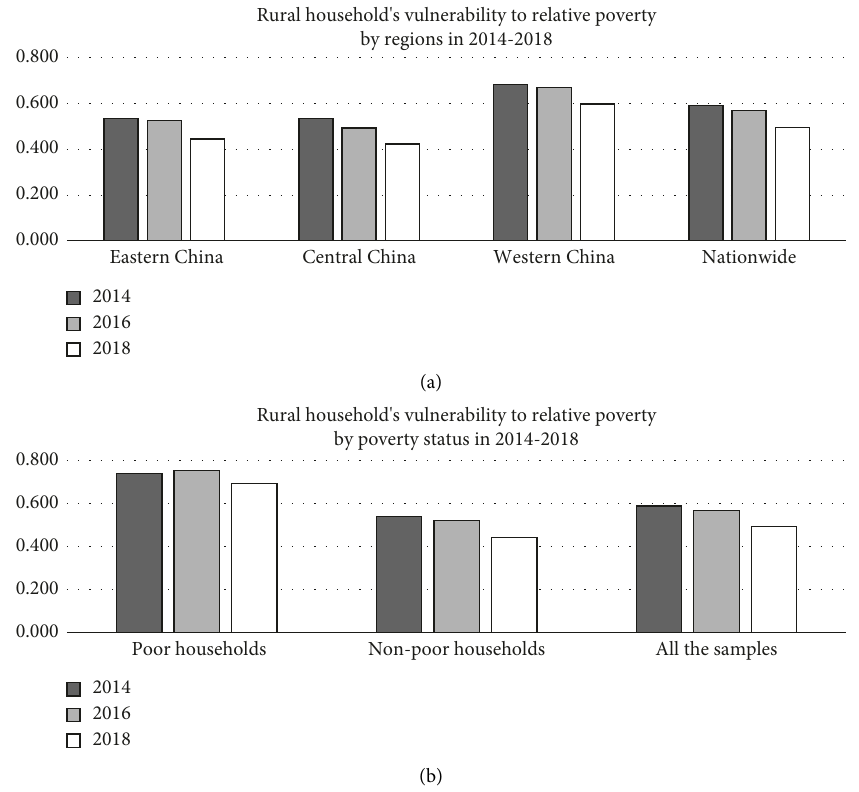
Figure 1: Stylized facts of rural household’s vulnerability to relative poverty during